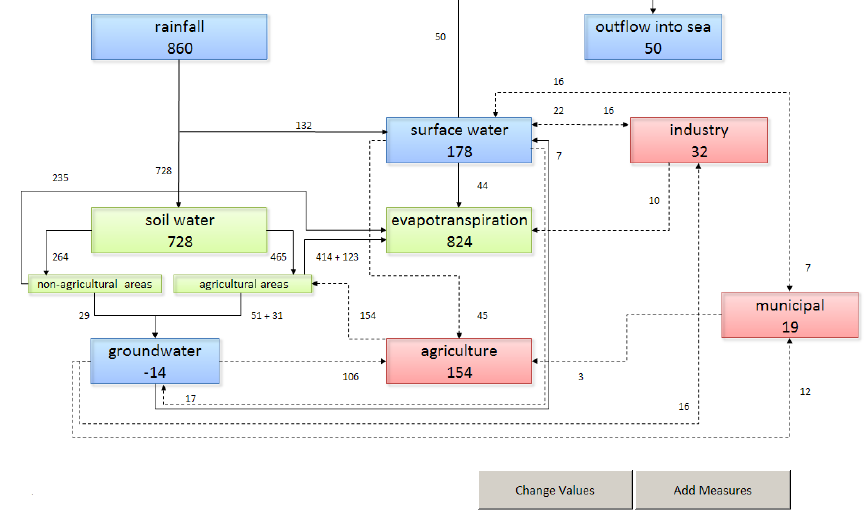
Figure 3. The water balance meta-model depicted as a flowchart with the main components and water flows.